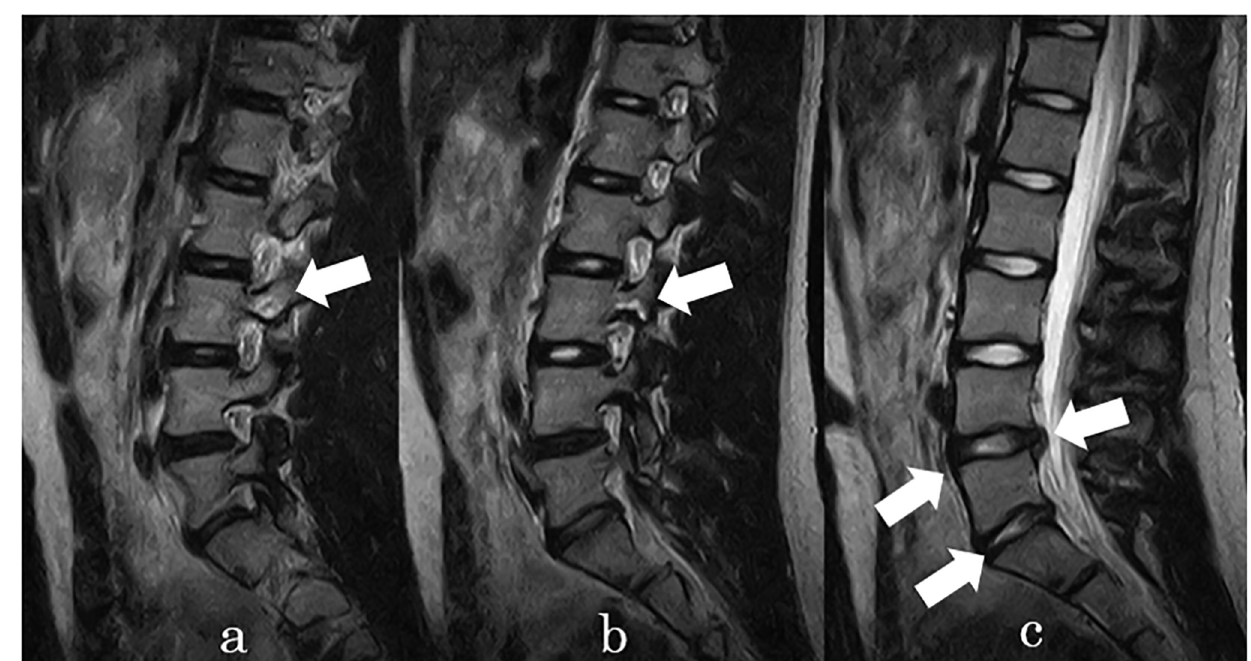
Fig 1. Representative case (patient 7). Bilateral lumbar spondylolysis at L3. (a, b) Disc degeneration at L4/5. L5/S1. (c) Disc herniation at L4/5.